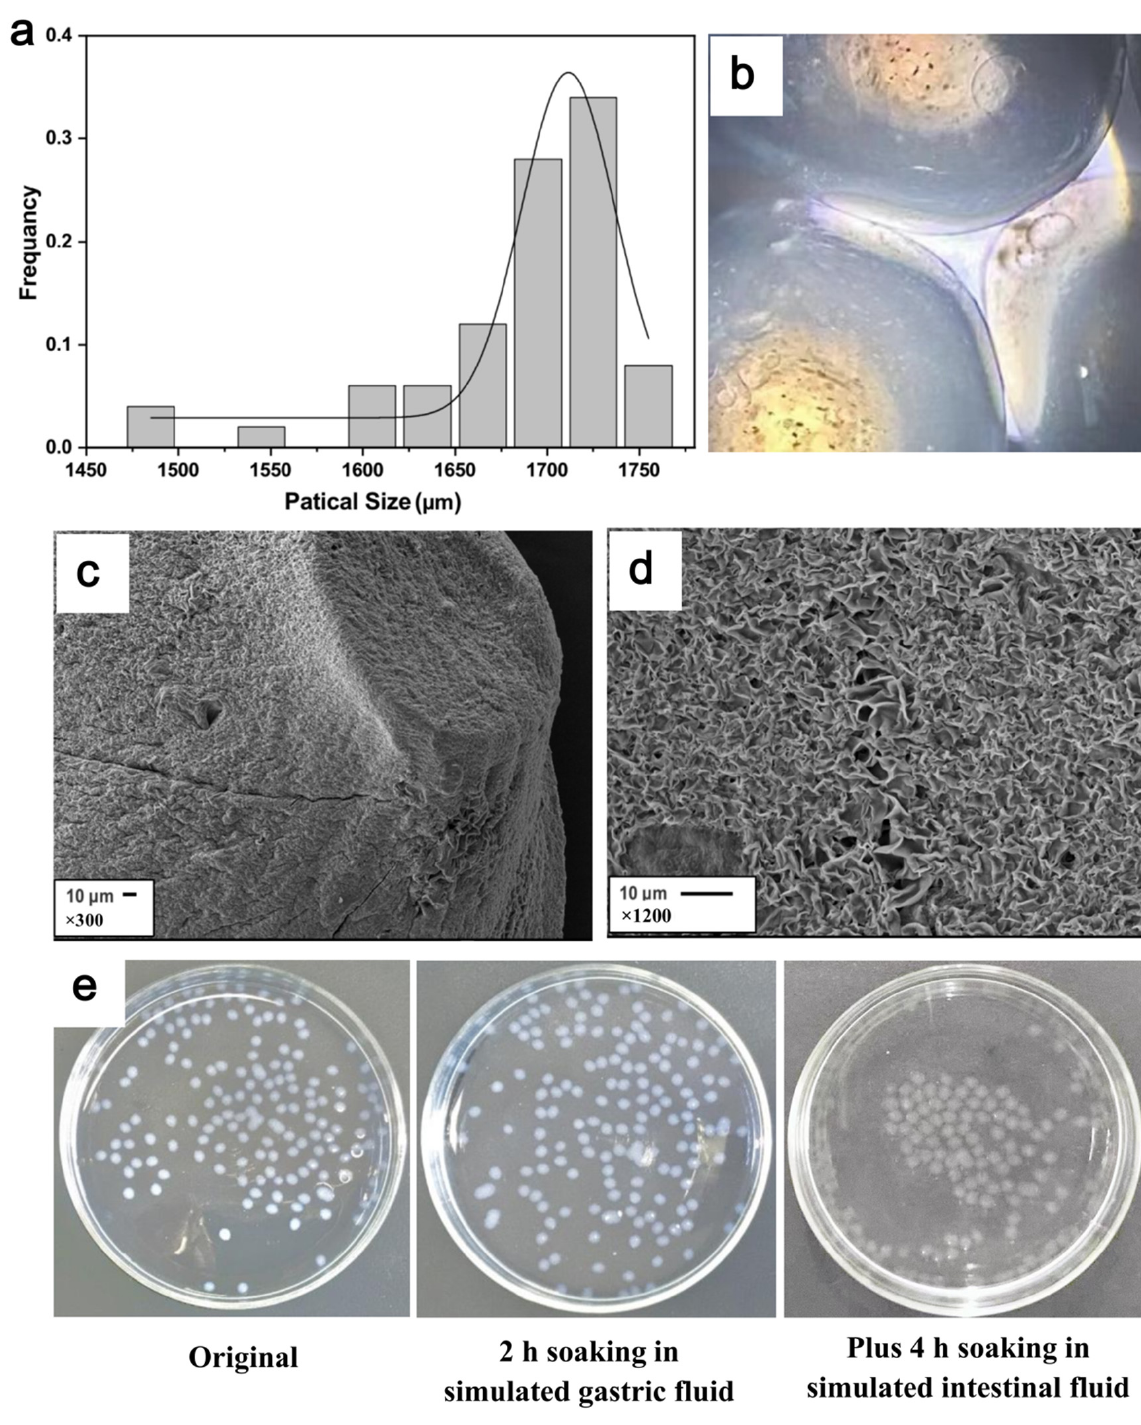
Figure 4. Characteristics of MGS capsule appearances. ( a ) particle size distribution; ( b ) micro-graph; ( c ) SEM morphology under 300 magnifications; ( d ) SEM morphology under 1200 magnification; ( e )macroscopic characteristics of MGS capsule’s changes after stimulated gastrointestinal environ- ments.